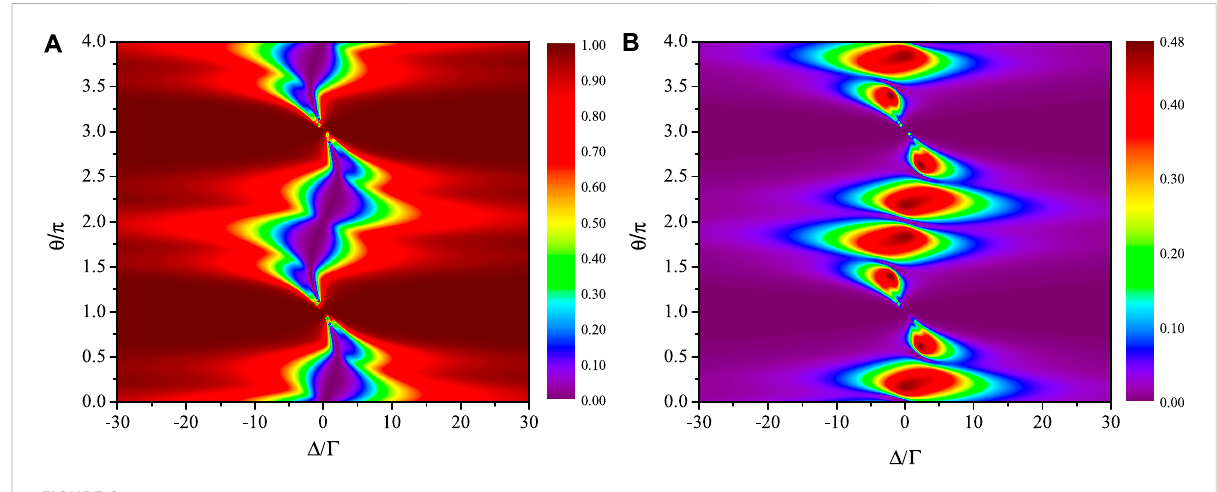
FIGURE 2 Transmission rates T m (A) and T n (B) as a function of the detuning Δ and the phase shift θ , in which the frequency detunings are equal ( Δ a = Δ b = Δ ), and the two atom-waveguide coupling strengths are the same ( Γ a = Γ b = Γ ). A dark purple sinusoidal shape implies T m = 0, and T n can reach its maximum value of 0.48. The transferred rate T n + R n ( R n = T n ) of the photon from the input waveguide m into the targeted waveguide n is 0.96. The other parameter is g =